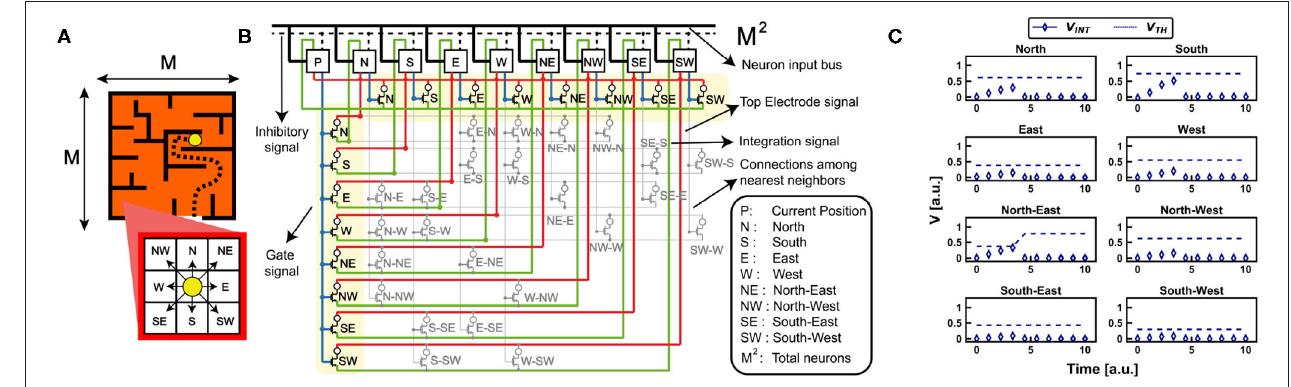
FIGURE 7 | (A) Case study maze for the investigation of the reinforcement learning capabilities of the bio-inspired RNN. (B) The synapses of the RNN link symmetrically each neuron to and from the nearest neighbors. At every position P, the neuron sends a signal to the synaptic gates of its neighbors. When one neuron integrates enough current to overcome its internal threshold, it fires and inhibits all the network. Every firing activity maps the movement of the agent. The schematic of the circuit also shows the connections among the nearest neighbors. (C) Experimental measurement for a single movement of the agent inside the case study maze. The nearest neurons start to integrate current until one (North-East neuron) overcomes the threshold and fires. Note that the fire activity of the neuron causes an increase of the PCM